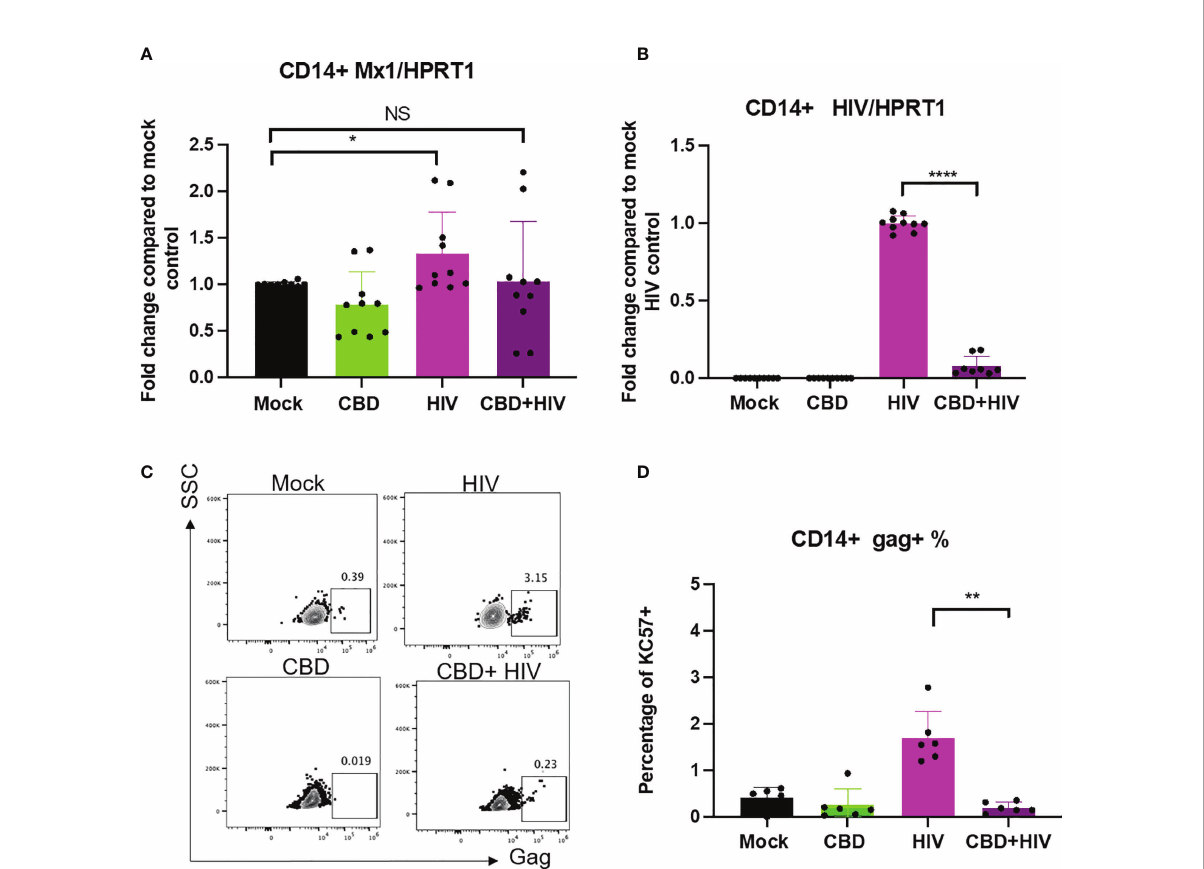
FIGURE 6 CBD affects HIV viral spread in primary macrophages. CD14+ cells were magnetically sorted and differentiated with M-CSF for 5 days followed by treatment with vehicle/CBD overnight. After treatment, cells were infected with HIV for 24hrs with vehicle/CBD treatment for another 8 days. (A) ISG MX1 expression level as measured by real time PCR. (B) HIV RNA level as measured by real time PCR. (C) Representative fl ow plot of cells stained with anti-gag antibody after 8 days of infection. (D) Summary of gag+% cells. *p<0.05, **p<0.005, ****p<0.0001, NS, non- signi fi